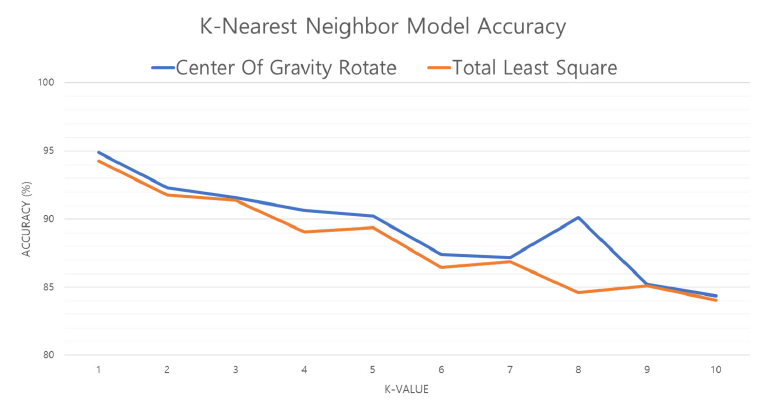
Figure 18. Performance evaluation of K-NN model against k (nearest neighbors).